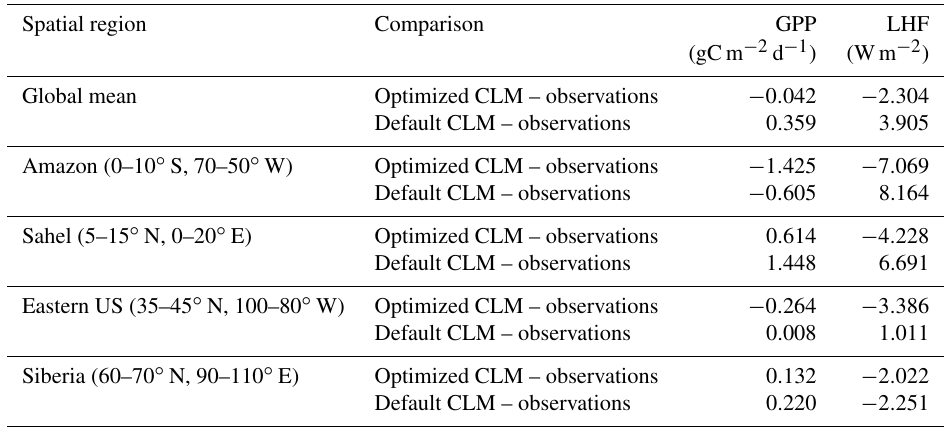
Figure 10. PC1, PC2, and PC3 for GPP (a) and LHF (b) comparing observations, model simulations, and emulator predictions. Observational estimates from FLUXNET are shown as red bars, CLM default values are shown as black bars, the optimized NN predictions are shown as blue bars, and the results of the CLM test case with optimal parameters are shown as green bars. Table 2. Global and regional mean biases for GPP and LHF comparing CLM with optimized parameters and the CLM default configuration with